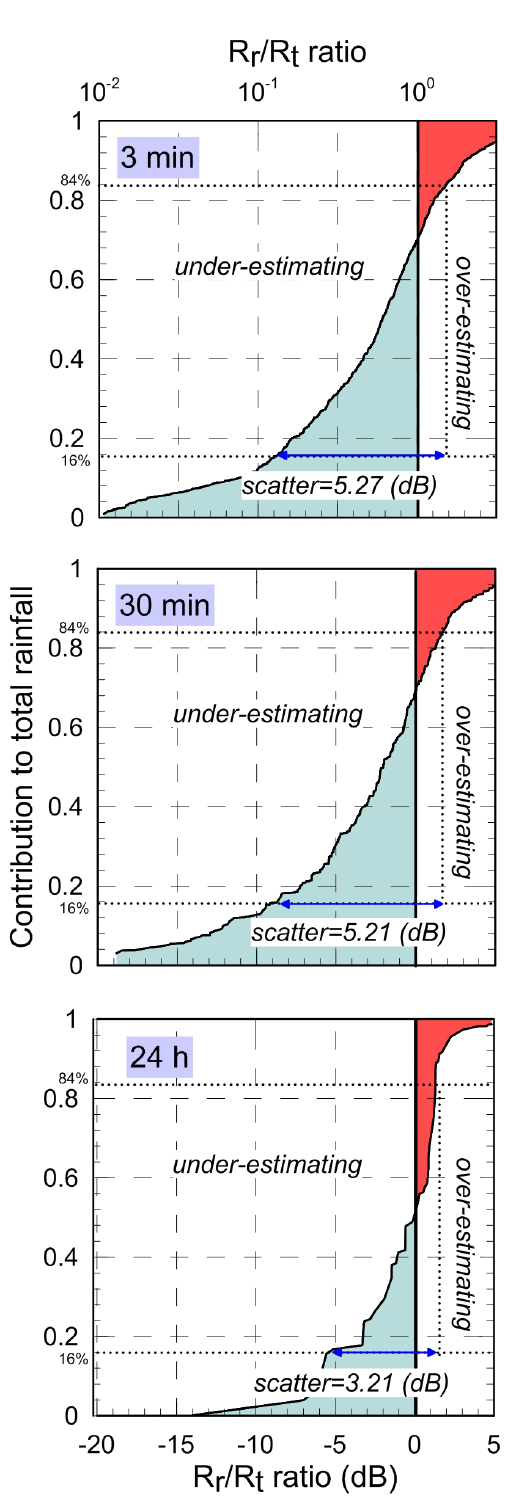
Fig. 9. Cumulative distribution (weighted by contribution to total rain amount) of the radar-to-true rainfall ratio ( R r /R t , in dB) (see Germann et al., 2006) for different